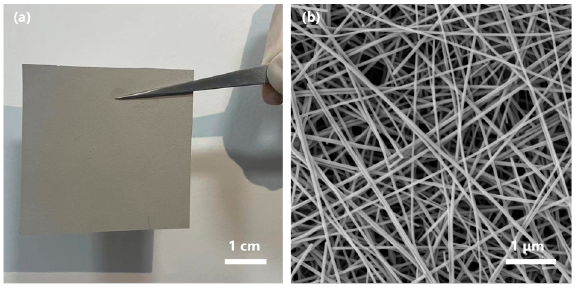
Figure 4. Images of silver nanowire film. ( a ) Physical appearance, ( b ) Microscopic morphology.